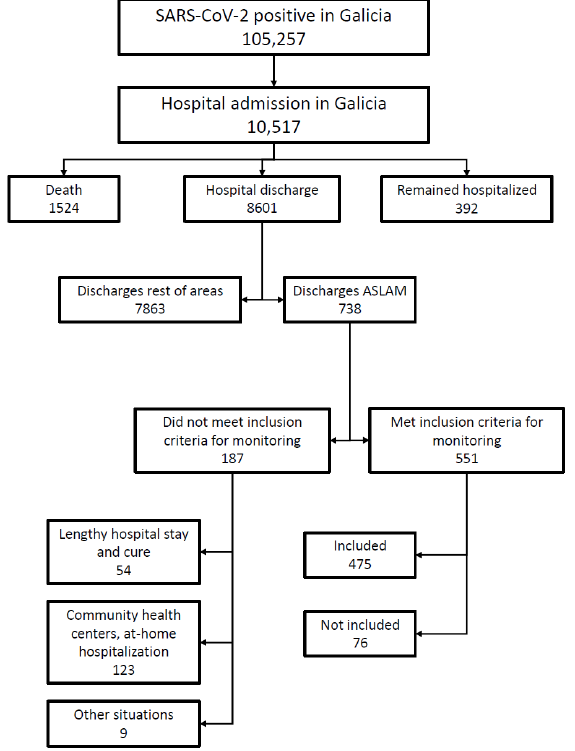
Figure 1. Flowchart of readmitted discharged patients in the autonomous community of Galicia. Table 2. Characteristics of patients discharged from ASLAM hospitals.